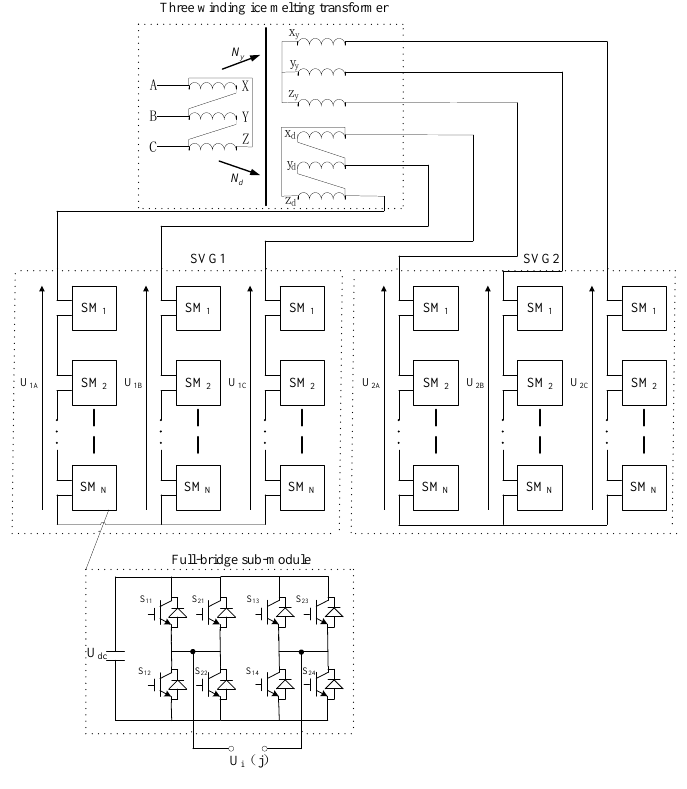
Figure 2. SVG structure.